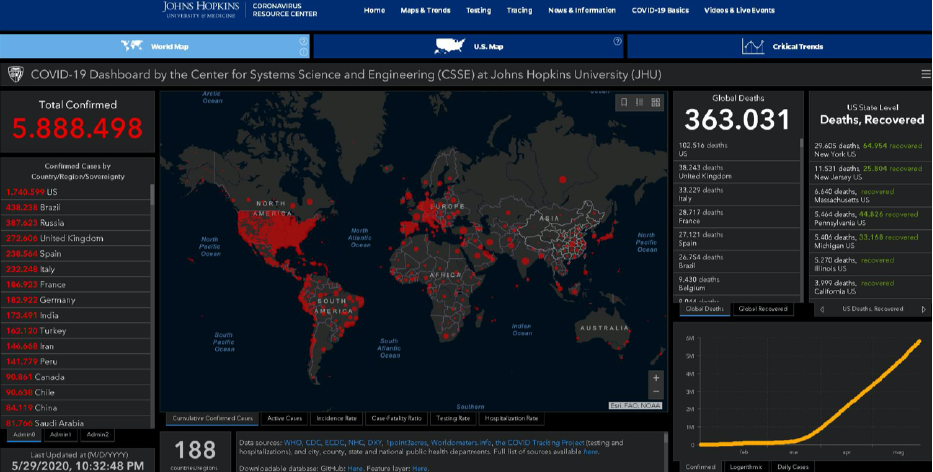
Figure 10. COVID-19 Johns Hopkins Dashboard